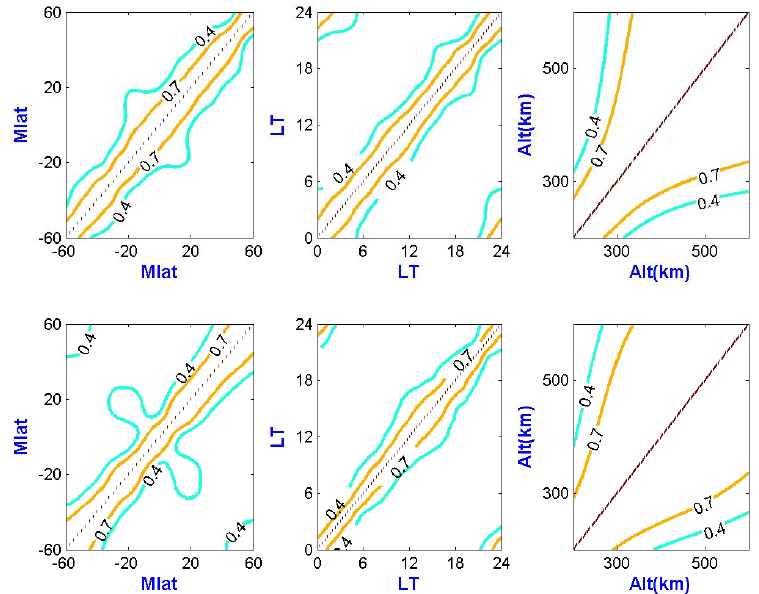
Fig. 1. Correlation coefficients’ sketch map. From left to right panels are meridional, zonal, and vertical correlation coefficients, respectively. Meridional correlation coefficients are shown between mlat –60 ◦ –60 ◦ , and the top and bottom panel corresponds to night and day time. Zonal correlation coefficients are shown between different local times, and the top and bottom panels are for mlat 40 ◦ and 0 ◦ , respectively. Vertical correlation coefficients are shown between 200–600km, and the top and bottom panels are for night and day time, respectively.